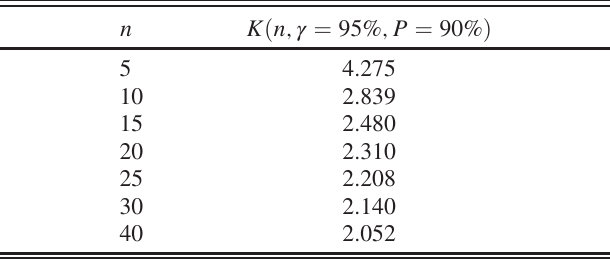
TABLE IV. K values dependent on n , γ , and P